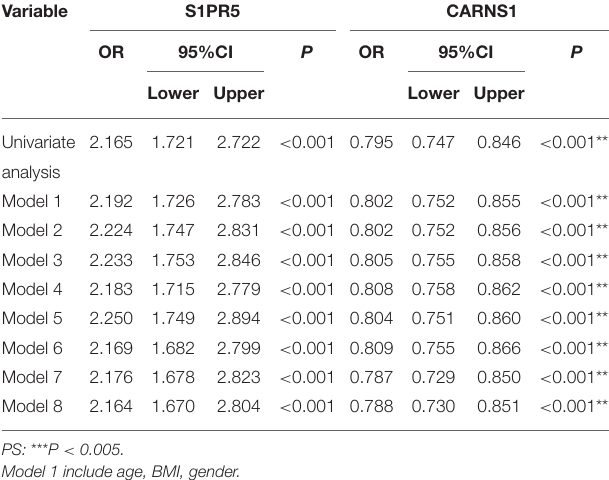
TABLE 3 | Univariate and multivariate logistic regression analysis to identify mRNAs as independent predictors of CHD. Variable S1PR5